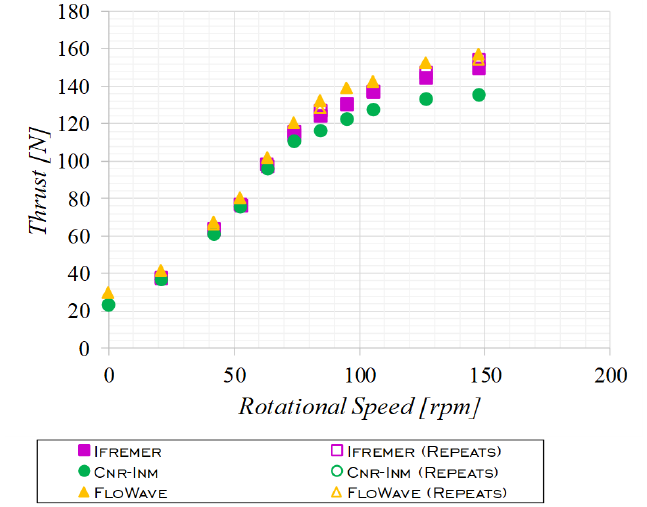
Figure 14. Case 1: Variation of the time average of the power ( top ) and thrust ( bottom ) measurements against turbine rotational speed for cases at 0.8 m/s, taken at each of the facilities with the repeated tests when available.